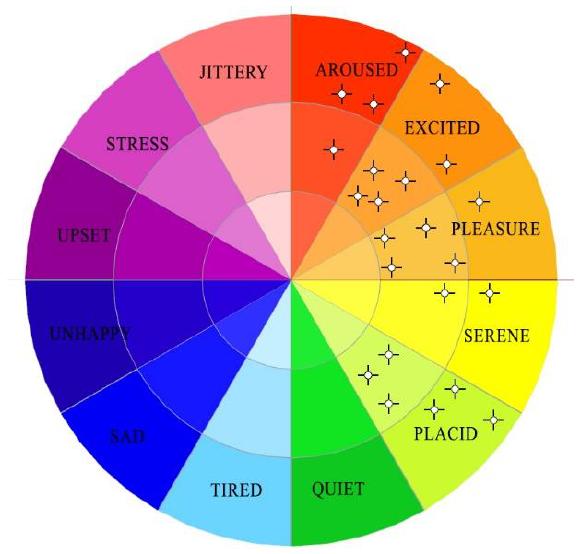
Figure 3 -The circumplex model 12-PAC with a tripartite division according to the intensity of the emotion, at the center the neutral value and the arrangement of some points related to a survey as a function of the two cognitive